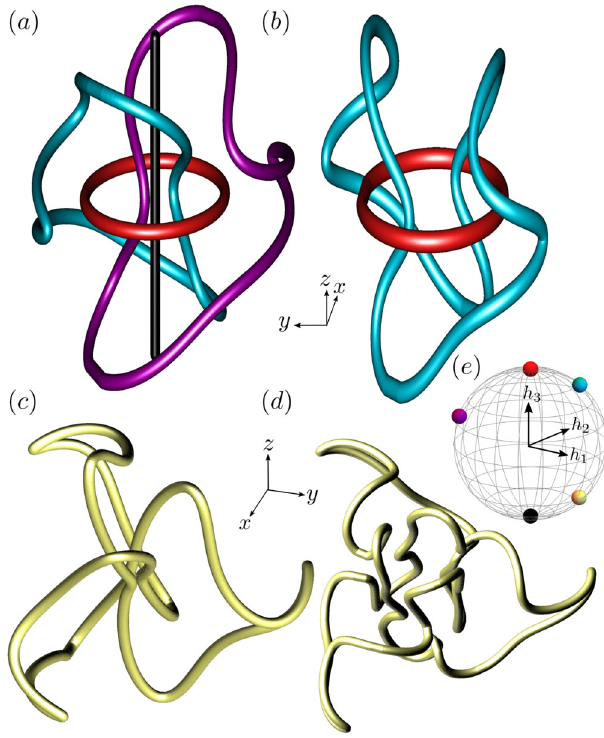
Fig. 3 Links and knots in particle-like Hop fi on optical excitations. a – d Real space preimages of Hop fi ons with different Hopf charge, Q H , where each preimage corresponds to a point on the Poincaré sphere S 2 ( e ). Hop fi on with a Q H = 1, b Q H = 2, where preimages interlink once and twice, respectively, and organise around the preimages of the vortex ring (red circle) and vortex line (black line corresponding to a circle of in fi nite radius). c , d Q H = 6 Hop fi ons with trefoil knot preimages. The Hop fi ons are created using the light fi eld in Eq. (8) with l equal to a 1, b 2, c , d 3, and the y -polarised light component replaced in c by a two-photon transition and in d by the LG beams of Eq. (13). The beam widths ( w 0 , w 1 , w 2 )/ λ = (2, 3,